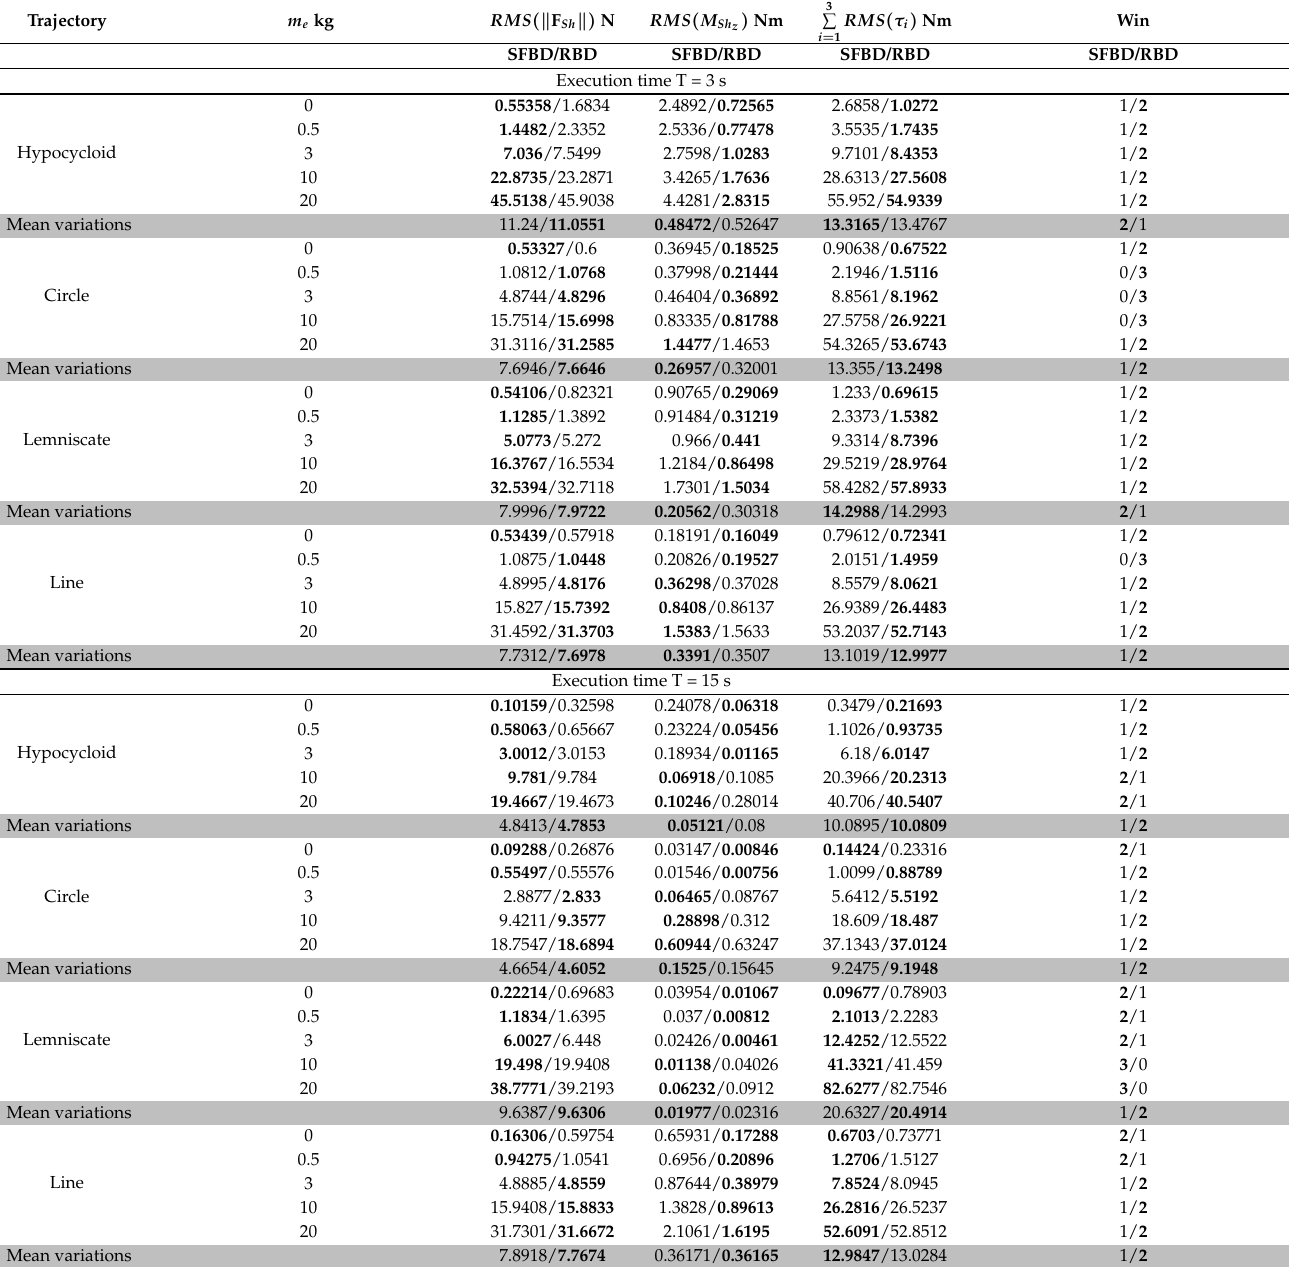
The boldface number indicates the best performance between the design approaches. The shadowed rows “Mean variations” indicate the average of the difference between the RMS value of the indicators with two different masses m e in the